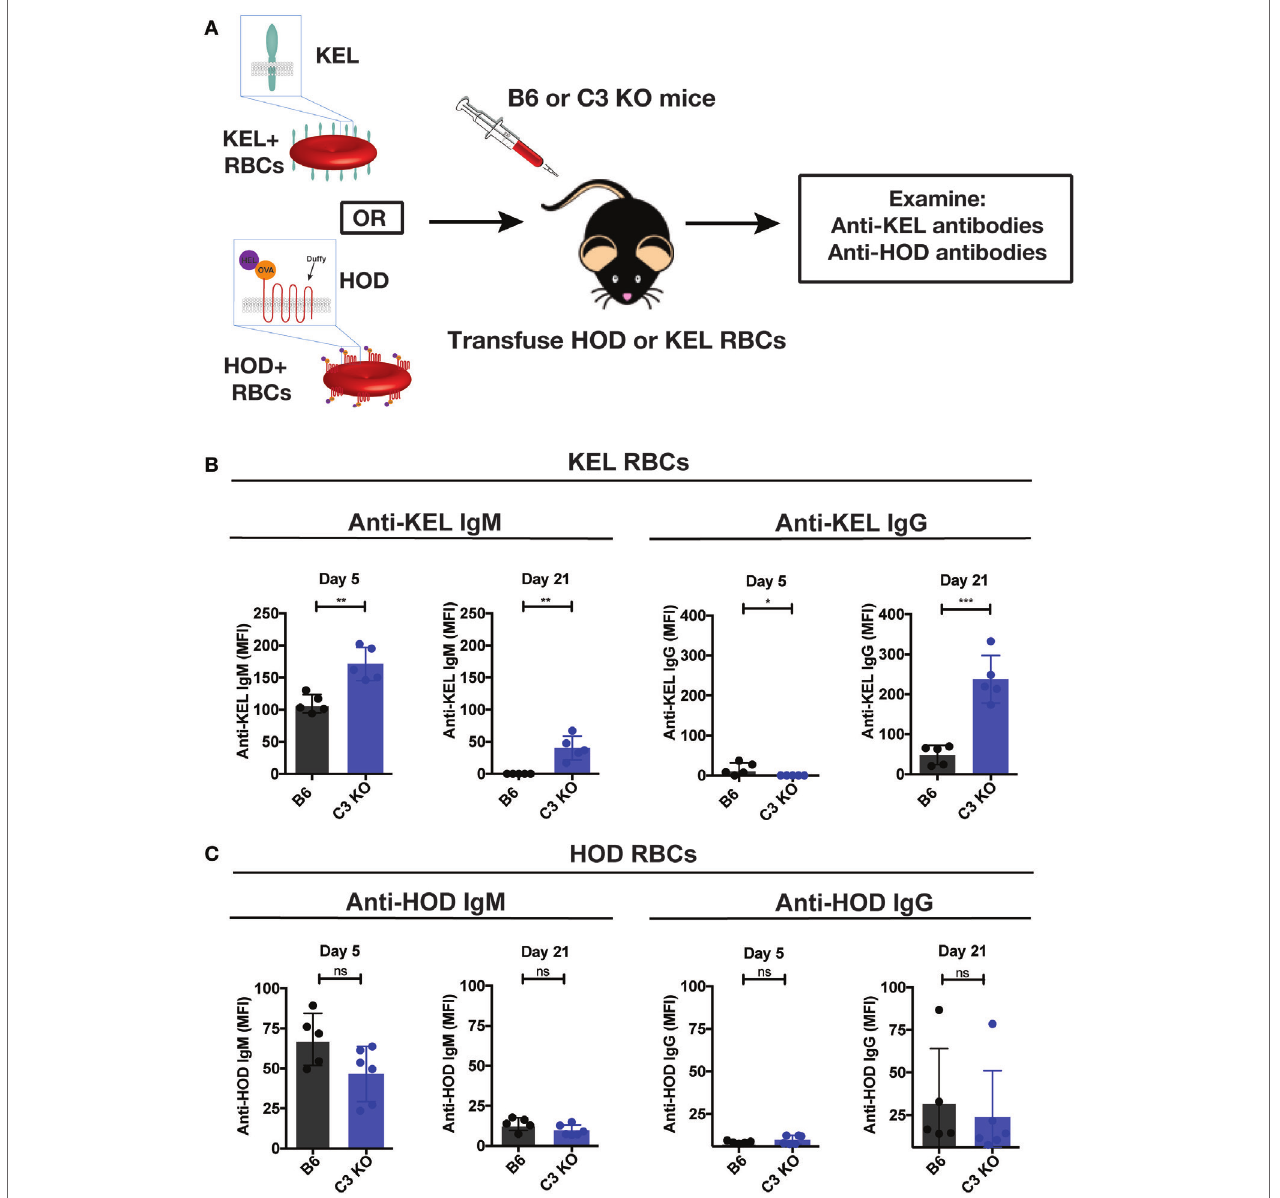
FigUre 2 | Complement component 3 (C3) KO recipients exhibit an increased anti-KEL antibody (Ab) response following KEL red blood cell (RBC) transfusion. (a) Schematic overview of KEL or HOD RBC transfusion into B6 and C3 KO mice, followed by examination of anti-KEL or anti-HOD Abs, respectively. (B) Following exposure to KEL RBCs, serum from B6 or C3 KO recipients was assessed for development of anti-KEL IgM and IgG at days 5 and 21, respectively, following transfusion by flow cross-match. (c) Following exposure to HOD RBCs, serum from B6 or C3 KO recipients exposed to HOD RBCs was assessed for development of anti-HOD IgM and IgG at days 5 and 21, respectively, post-transfusion by flow cross-match. (B,c) *** p < 0.0002, ** p < 0.004, * p < 0.05 and ns = not significant. Means ± SD